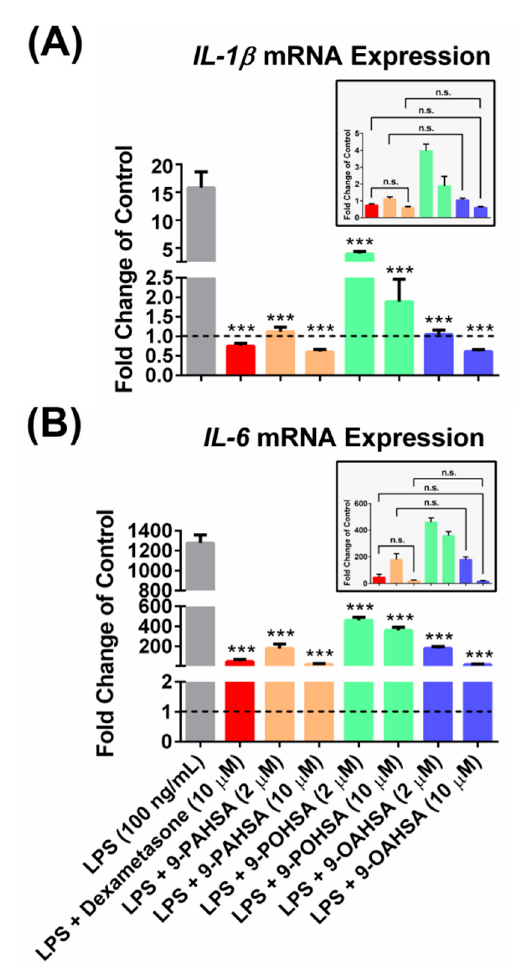
Figure 5. 9-POHSA and 9-OAHSA possessed anti-inflammatory effects. RAW 264.7 cells were treated with the indicated concentration of lipopolysaccharide (LPS, 100 ng/mL), 9-PAHSA, 9-POHSA, 9-OAHSA (2 and 10 µM), or co-treatments, where dimethyl sulfoxide (DMSO, Sigma, USA) was used as a vehicle control group. After 24 h, the cells were harvested and further processed for RT-qPCR. 9-POHSA and 9-OAHSA suppressed LPS stimulated cytokines IL-1 β ( A ) and IL-6 ( B ) gene expression. The dashed line across all bars to axis X indicated control(s) which assigned as one. Data are presented as mean ± SD, n = 4~5, (*** p < 0.001, n.s. = not